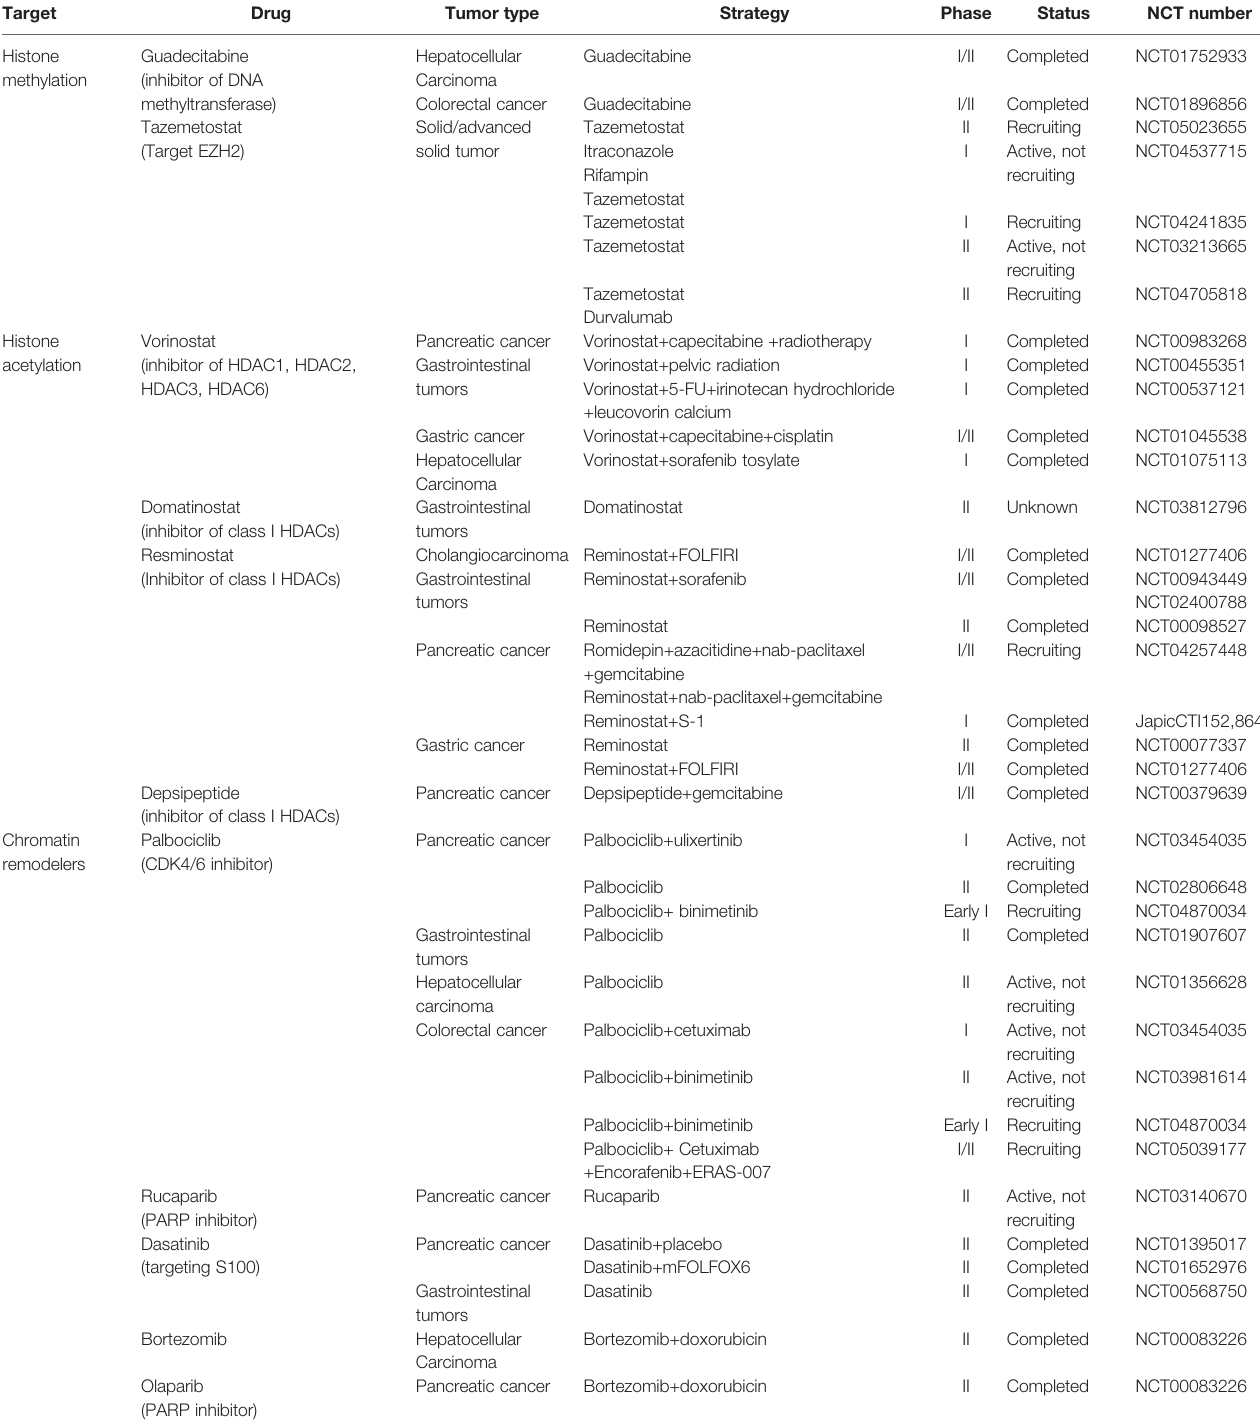
TABLE 3 | Clinical trials targeting epigenetic modi fi ers in digestive system